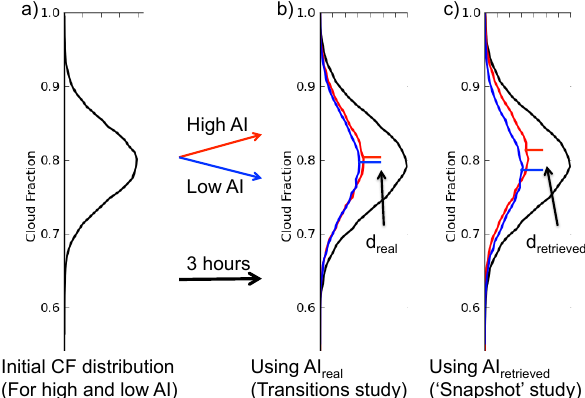
Fig. 10. Schematic demonstrating how the time of the aerosol re- trieval can affect d (CF). At the start of the timestep (a) , both the high and low AI populations have the same CF distribution. (b) De- spite starting with the same CF, these populations evolve differently, generating d real (CF) at the end of the timestep. (c) Using the AI re- trieval from the end of the timestep (AI retrieved ) gives a larger CF difference d retrieved (CF), due to aerosol humidification and cloud contamination, which increase with